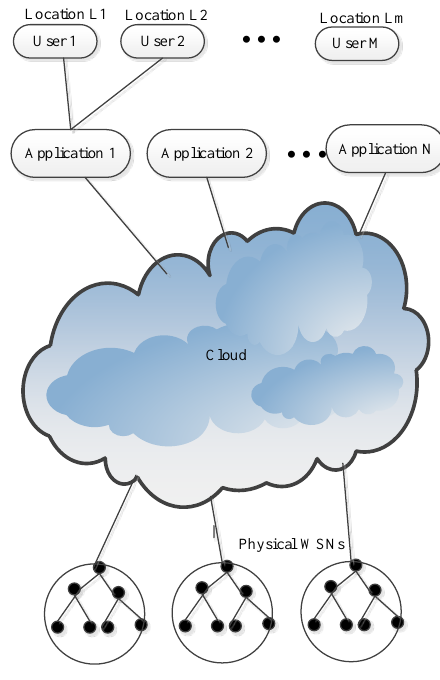
Figure 1. Location based IoT–cloud